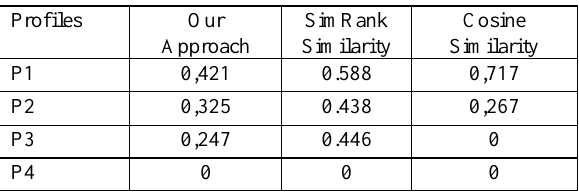
Table 1. SimRank and Cosine